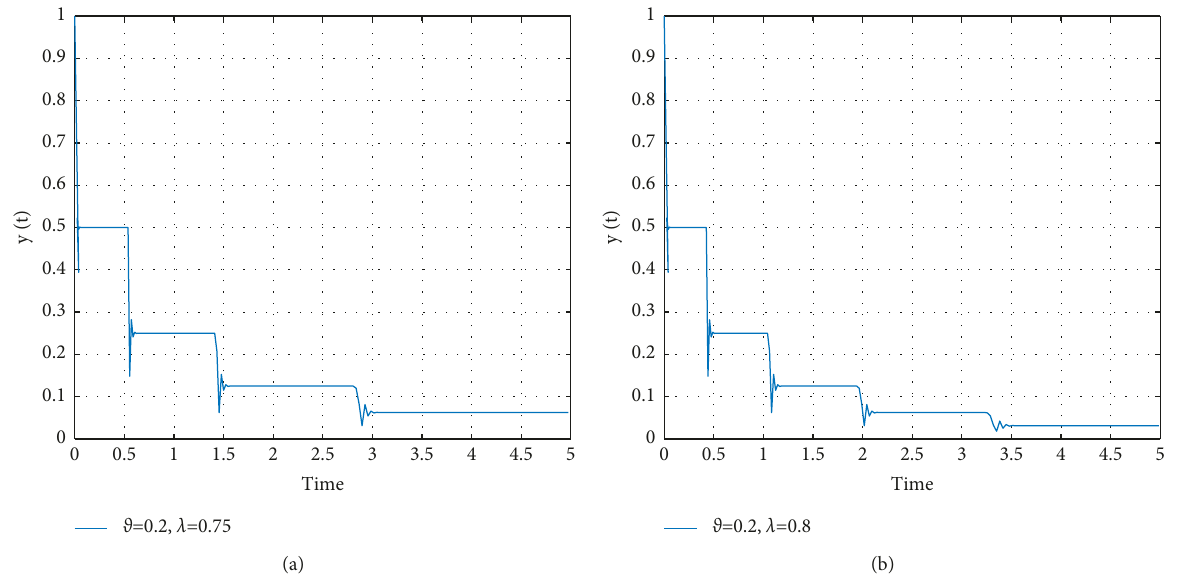
Figure 4: Numerical simulations of model (36) with ϑ � 0 . 2 and λ � 0 . 75 (a), λ � 0 . 8 (b).